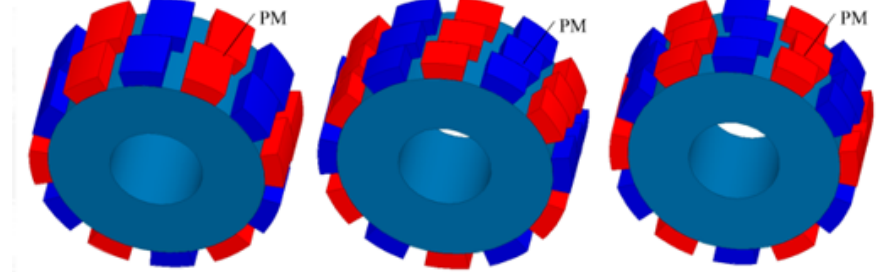
Figure 3. Example of changing the arrangement of permanent magnets, valid only for surface magnets, called ”rotor